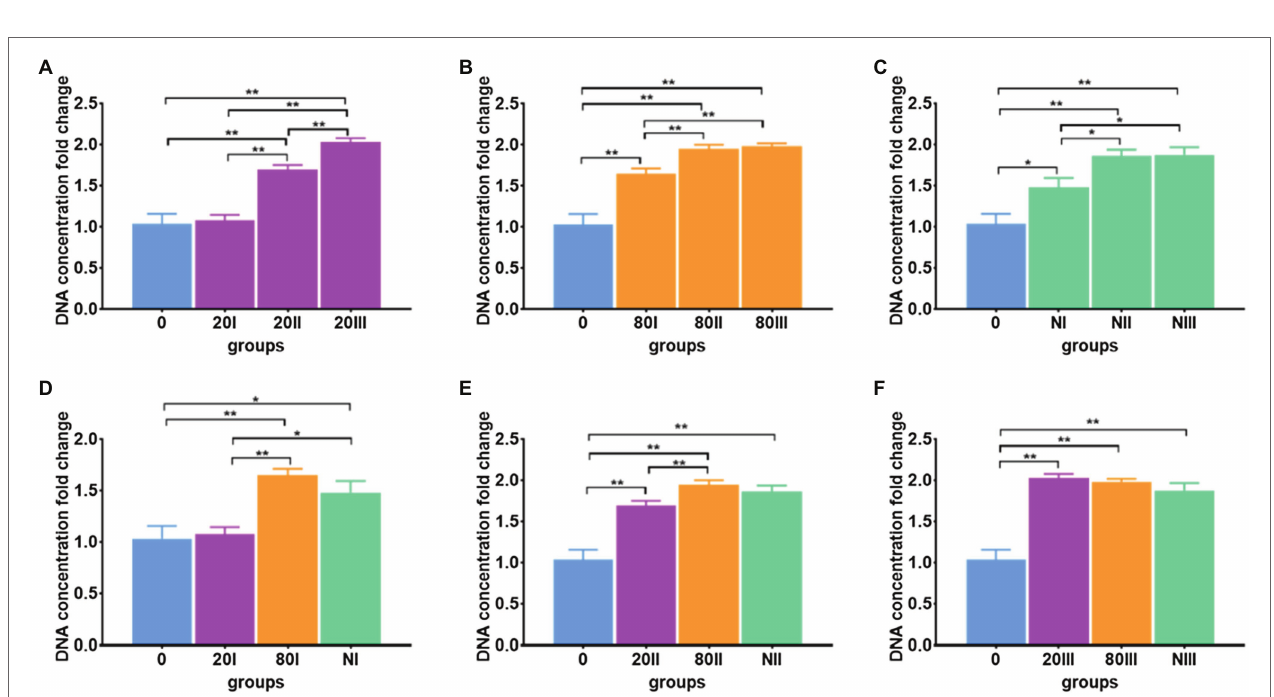
FIGURE 4 | Freeze-thaw cycle number-dependent DNA extraction efficiency. (A) The freeze-thaw cycle-dependent DNA extraction efficiency for meconium frozen at − 20 ° C; (B) The freeze-thaw cycle-dependent DNA extraction efficiency for meconium frozen at − 80 ° C; (C) Freeze-thaw cycle-dependent DNA extraction efficiency for meconium frozen in liquid nitrogen; (D) The DNA extraction efficiencies with one freeze-thaw cycle; (E) The DNA extraction efficiencies with two freeze-thaw cycles; (F) The DNA extraction efficiencies with three freeze-thaw cycles. The corresponding data were shown in Supplementary Table S5 . * P < 0.05, ** P <